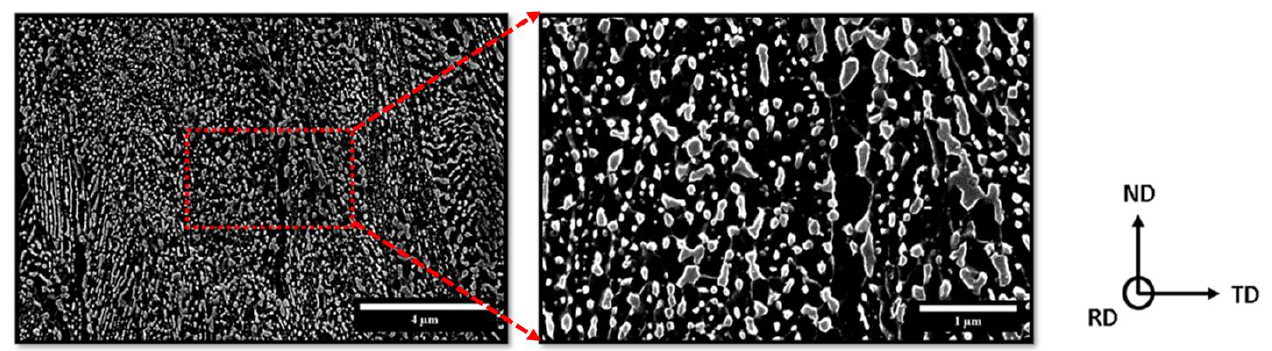
Figure 1. Micrographs of the as-received sample, labeled as AR.